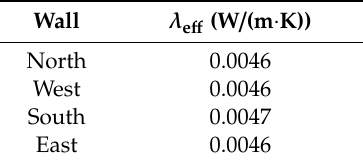
Table 4. E ff ective thermal conductivity of the VIP layers for the four walls, taking into account the pattern of the